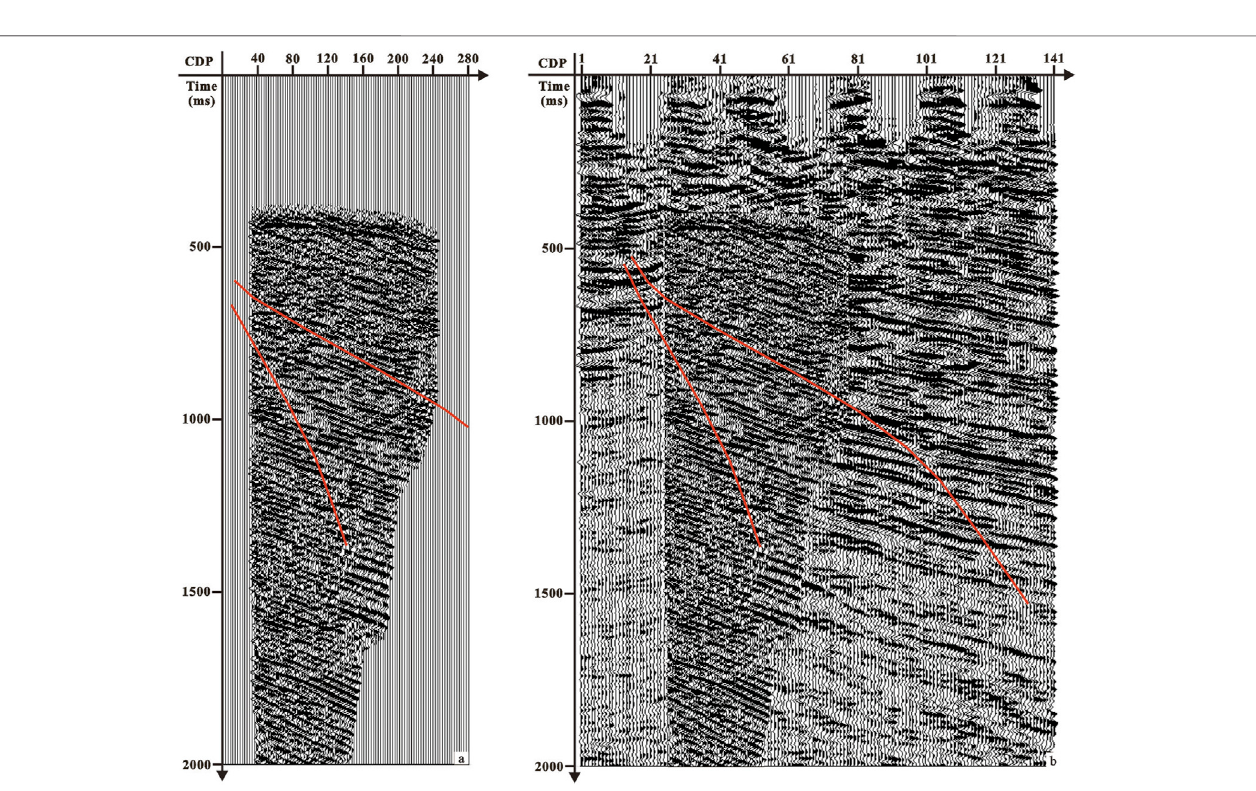
FIGURE 13 | Imaging results. (A) Section of crosswell seismic inverse Fresnel beam stack imaging and (B) overlapping map of crosswell seismic and ground seismic imaging.